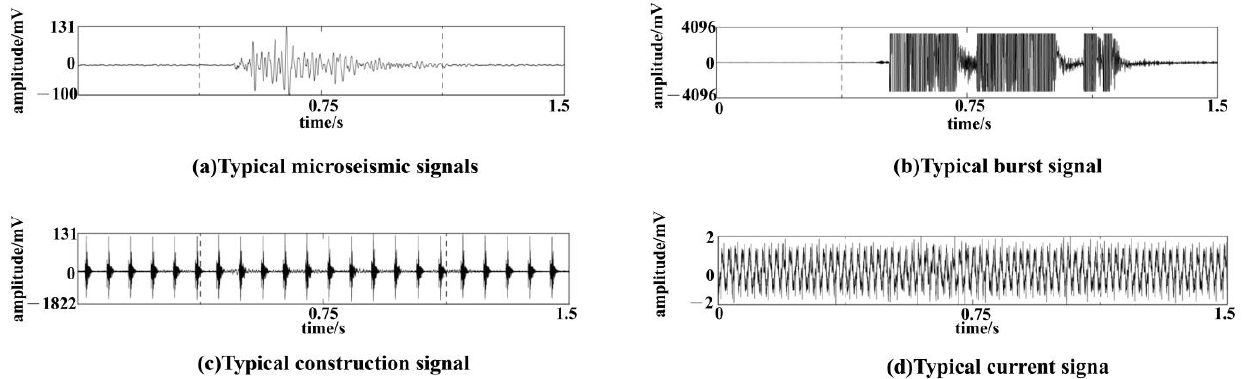
Figure 5. Waveforms of typical signals.